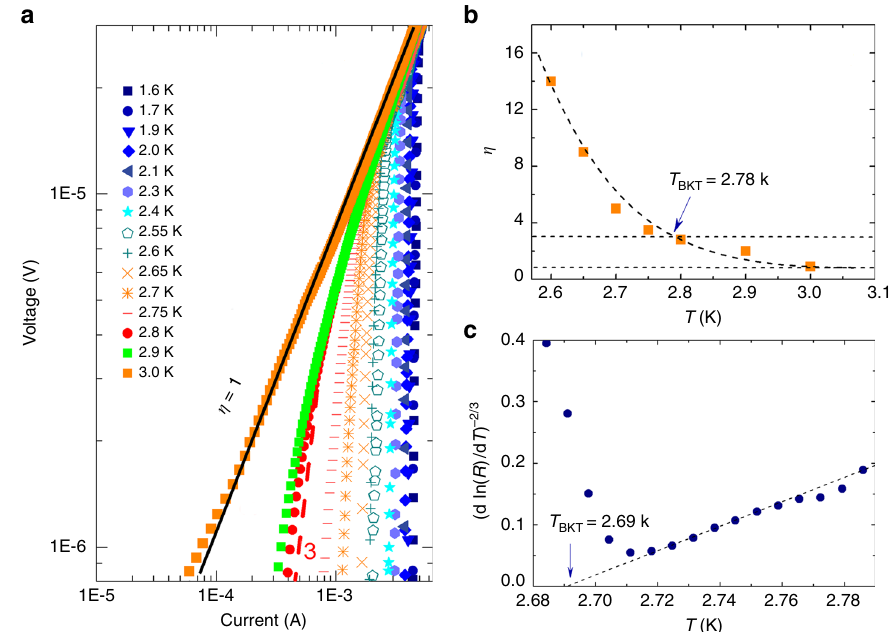
Fig. 5 Quasi-two-dimensional nature of superconductivity in AuTe 2 Se 4/3 . a I − V curves plotted in a log – log scale at various temperatures near T c . Dash lines represent the η = 1 (black) and 3 (red) curves, respectively. b Temperature dependence of the exponent η deduced from the power-law fi tting. Two straight dash lines represent the η = 1 and 3. c R ( T ) curves plotted as [dln( R )/d T ] 2/3 versus T . The dash line extrapolates the expected BKT transition at T BKT